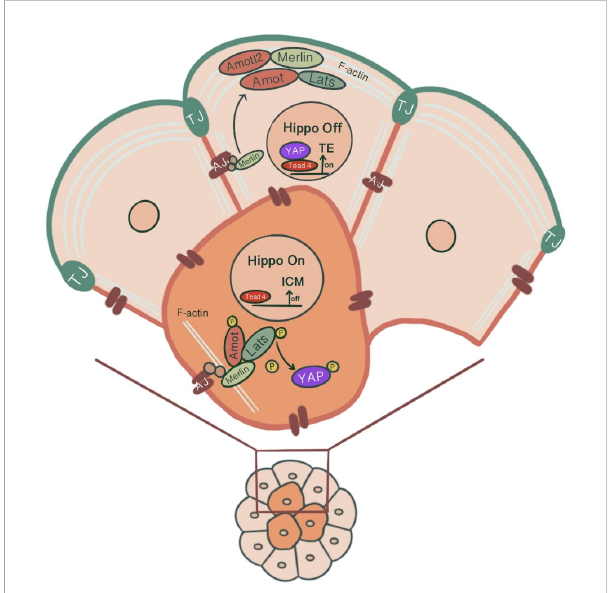
FIGURE 3 Differential modulation of the Hippo signaling pathway in inner and outer cells of the preimplantation embryo, in fl uenced by junction- associated scaffold protein angiomotin (Amot) and its interaction with tight junctions & adherens junctions. In outer cells, Amot co- localizing with ZO-1 causes apical F-actin-mediated suppression of the Hippo signaling pathway. Through sequestration of Amot to the apical membrane domain via the Par-aPKC complex, Yap, which can translocate to the nucleus, causes outer cells to adopt TE fate via Tead4 activation and Cdx2 expression. In inner cells, the E- cadherin- b -catenin- a -catenin-Merlin-Amot complex acts as an upstream regulator of the Hippo signaling pathway through Yap sequestration at cytoplasm, repressing target gene